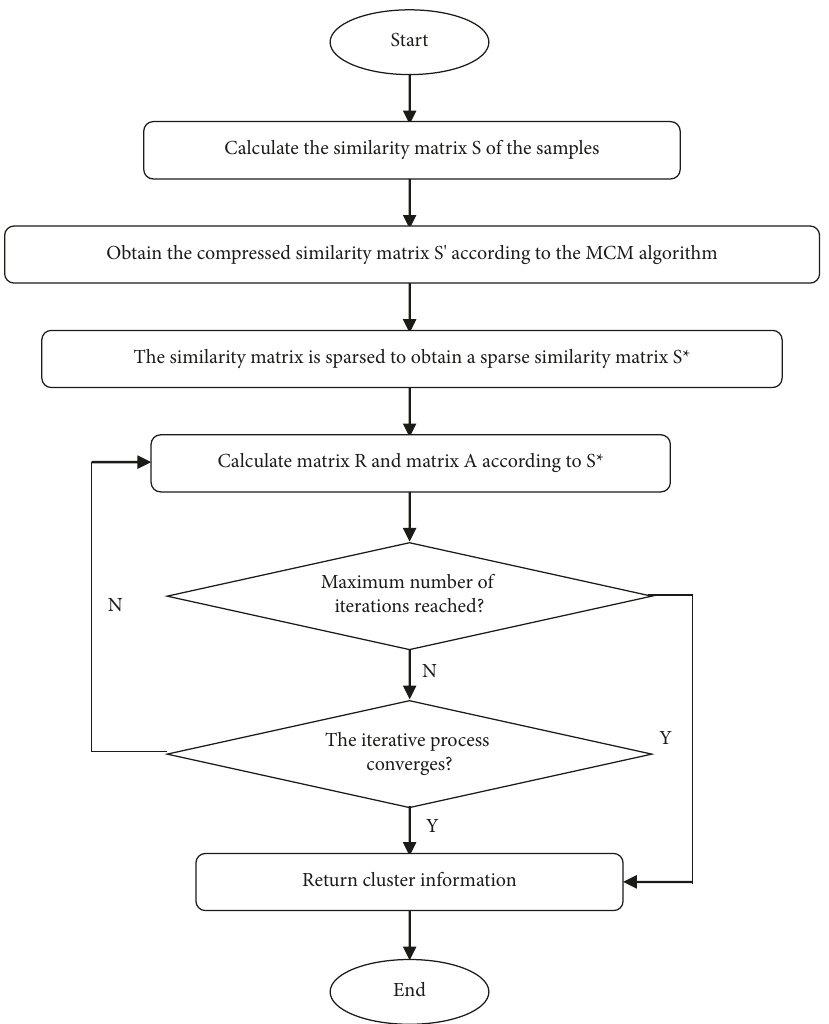
Figure 1: FastAP algorithm